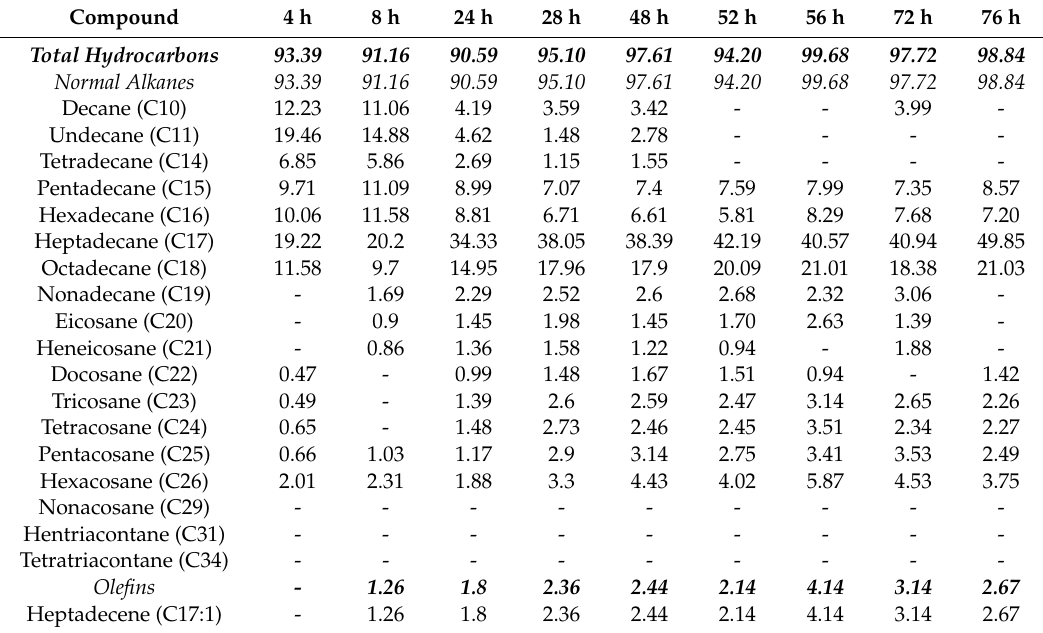
Table A3. GC-MS analysis of the liquid products from the catalytic upgrading of used cooking oil (75 wt.% in C12) over 20% Ni–5% Fe / Al 2 O 3 at 375 ◦ C and WHSV = 1.0 h − 1 , in 100% H 2 . Text in bold corresponds to compound classes comprising the individual compounds listed. Text in italics corresponds to compound sub-classes constituting the individual compounds detected. Values shown are wt.%.